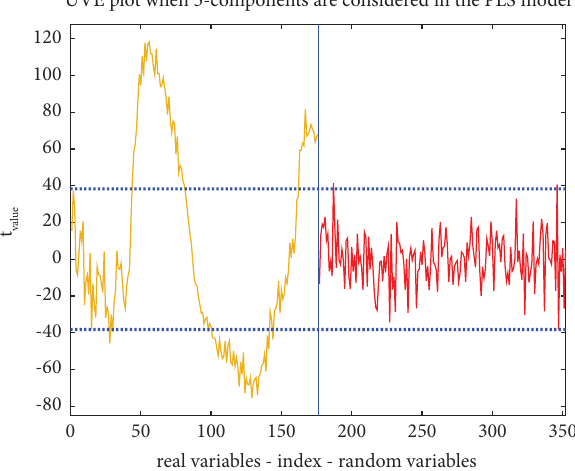
Figure 7: Process and results of A-RAW-UVE characteristic wavelength